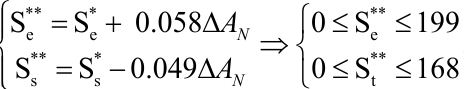
Table A8. Changes in restrictions on human assets of green tourism destinations in the final iteration of programming Basic variables